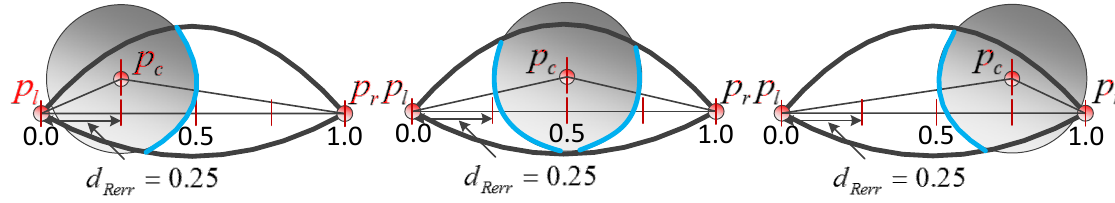
Figure 7: Iris edge marked with blue arc lines need to be detected according to the geometrical relationship of the position between the eye corners and the ideal iris